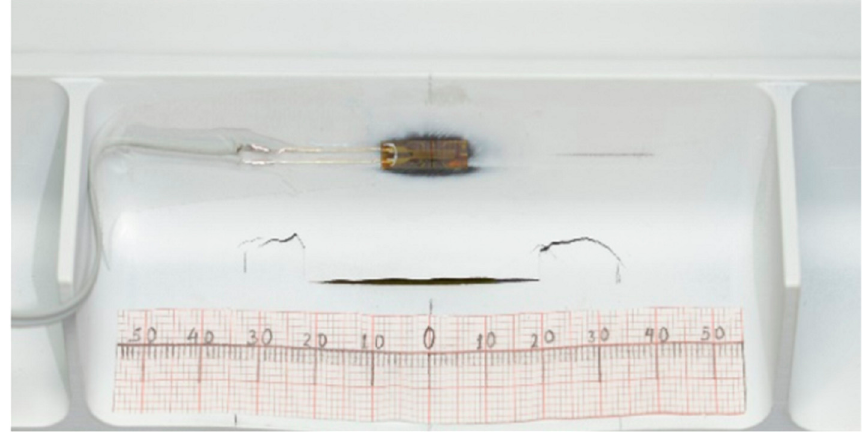
Figure 13. Transverse butt-joined elements as CAF in skin-stiffener structure [85].